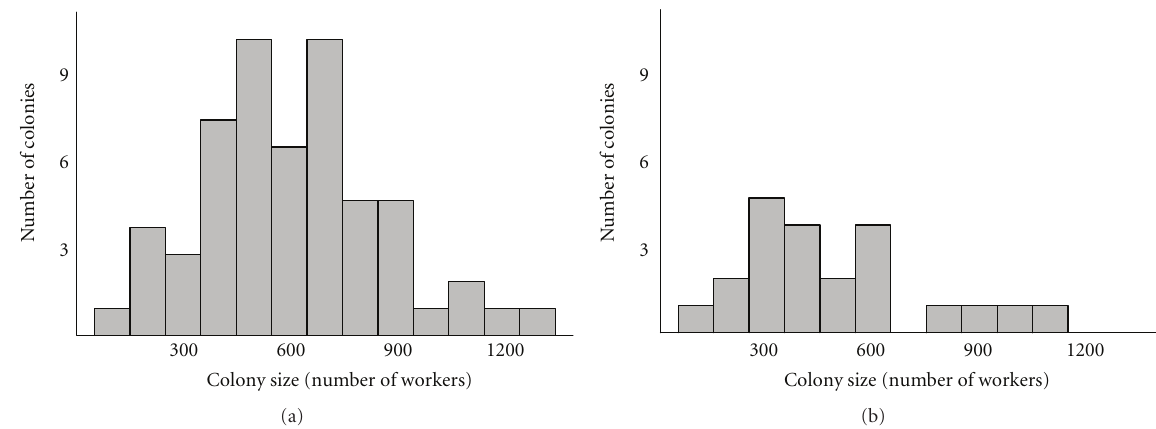
Figure 2: Distribution of the number of workers present in colonies that produced (a) or did not produce (b) sexual adults. Data are from Mohegan population trap nests collected in August of 2003 (17 colonies) and 2004 (65 colonies) [14].